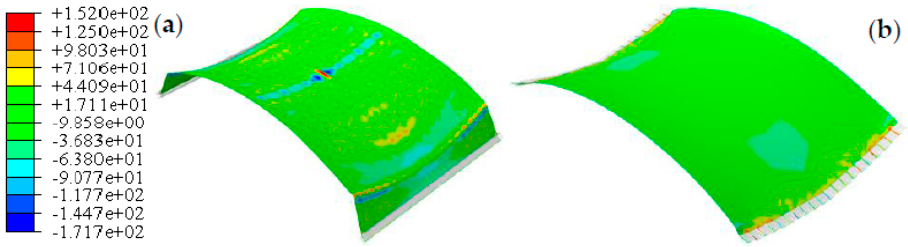
Figure 13. Transverse stresses distributions of the saddle-shaped part. ( a ) C-SF; ( b ) UC-SF.